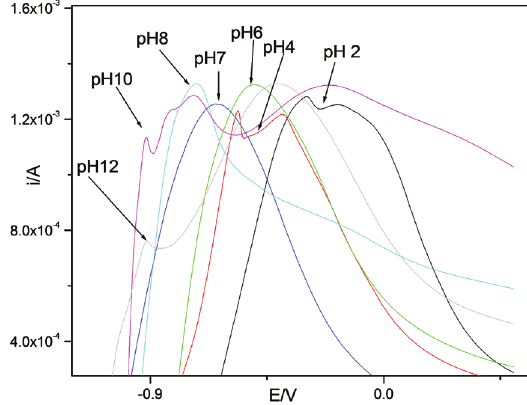
Figure 4. Sensitivity of the WO solutions with pH varying from 2 up to 10, for the linear region.